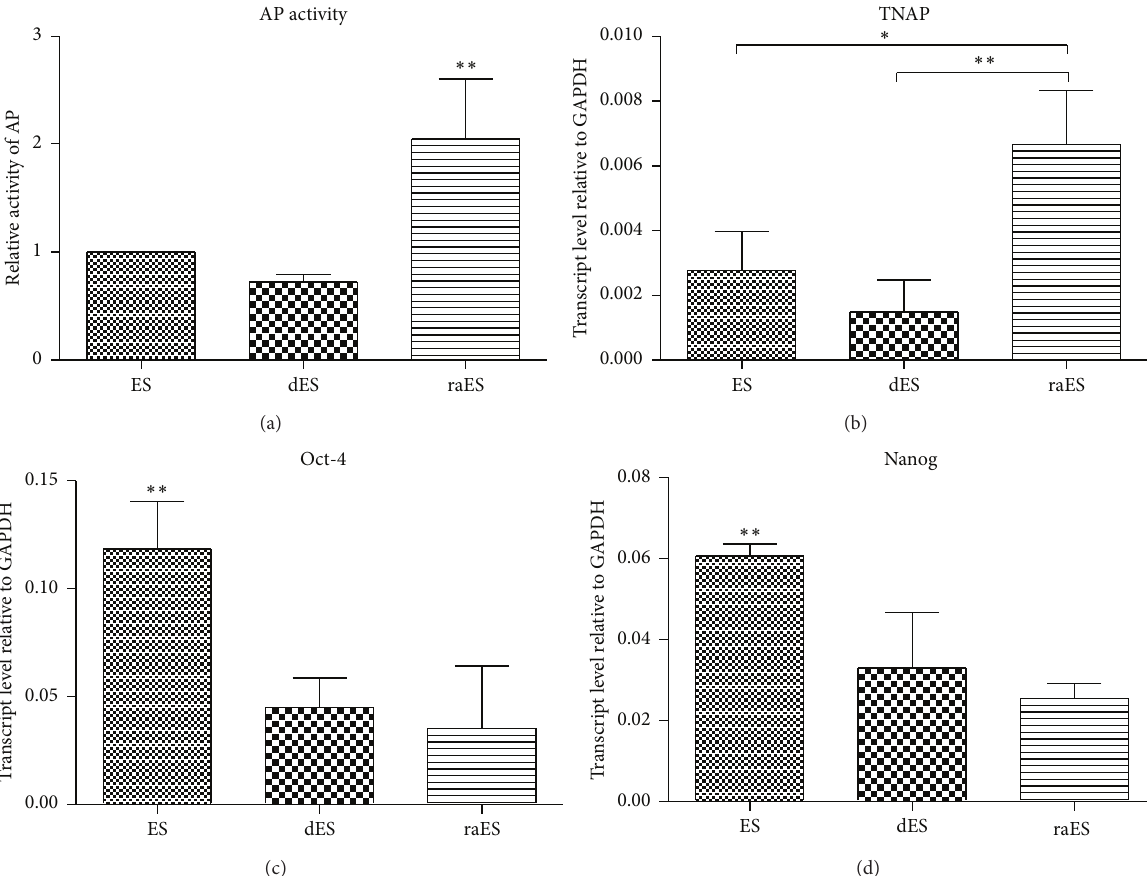
Figure2:RetinoicacidincreasedAPactivity(a)andmRNAexpressionofTNAP((b)qRT-PCR)inmouseEScells.Ontheotherhand,retinoic acid downregulated the expression of pluripotent markers Oct-4 (c) and Nanog (d) in the same manner as the spontaneous differentiation of ES cells through leukemia inhibitory factor withdrawal [75]. (ES: mouse embryonic stem cells; dES: spontaneously differentiating ES cells for two days; raES: retinoic acid-treated (0.2 𝜇 M) ES cells for two days). Details of the presented assay are as in Figure 1. Error bars indicate ± SD ( 𝑛 = 4 , ∗ 𝑃 < 0.05 ; ∗∗ 𝑃 < 0.01 , ANOVA post hoc Bonferroni’s Multiple Comparison